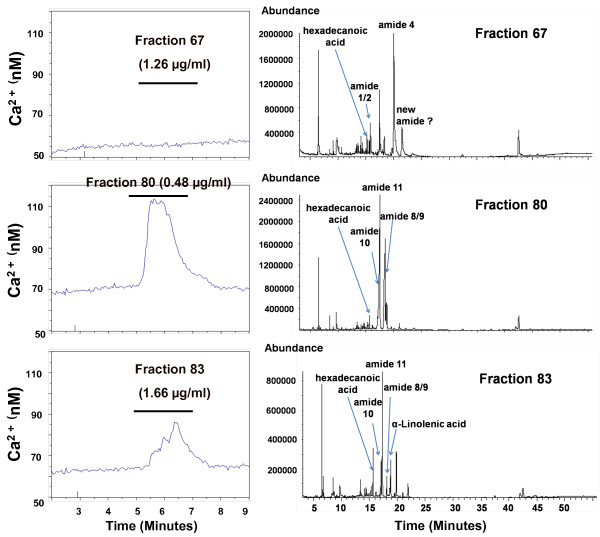
Different HPLC-separated fractions of E. purpurea root ethanol extract produce different effects on transient increase in the concentration of cytosolic Ca2+ in HEK293 cells. Three example traces are shown. (Statistical analysis of data from all fractions is presented in Figure 3.) Left: Average traces from the treatment of at least 20 cells per experiment, representative of three independent experiments. Fractions were applied according to their effects in the initial trials. For each of the bioactive fractions, the increase in cytosolic Ca2+ concentration was statistically significant as compared to 1% DMSO control treatment (p < 0.001). Right: GC-MS chromatograms of metabolites in these three fractions; chemically identifiable metabolites are labelled. Inactive fractions (e.g., fraction #67), were also applied after active fractions to confirm that the particular HEK293 culture used was indeed responsive to Echinacea extracts. The exposure time to each fraction is 2 min.